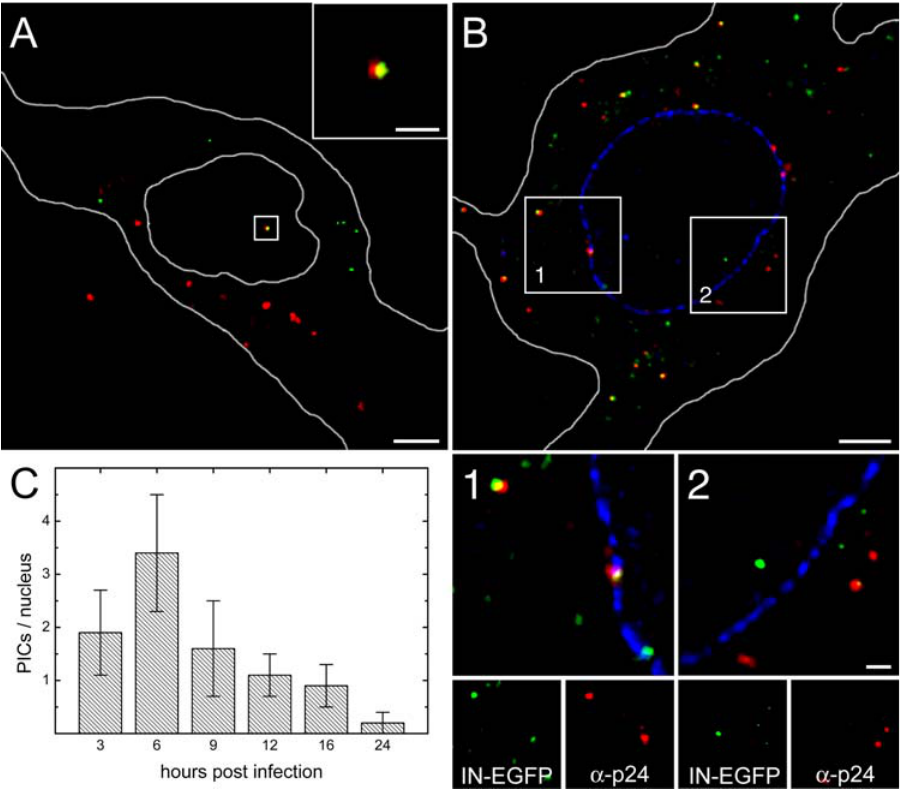
Figure 6. Nuclear HIV-IN-EGFP virions are functionally intact. (A) Merged image of a confocal section obtained from HeLa cells infected with HIV-IN-EGFP supernatants incubated with deoxynucleotides Alexa-594-dUTP. Yellow indicates full overlapping of EGFP and Alexa-594-dUTP signals. Cell and nuclear shapes are outlined in white. Bars, 5 m m and 1 m m in the whole frame and inset box, respectively. (B) Merged image of a confocal section obtained from HeLa cells infected with HIV-IN-EGFP supernatants (green) and immunostained with antibodies anti-p24 CA (red) and lamin A/C (blue). Yellow indicates full overlapping of EGFP and anti-p24 CA signals. Cell and nuclear shapes are outlined in white. Enlargements of frames 1 and 2 are shown in bottom panels along with the individual color images. Bars, 5 m M and 1 m m in the whole frame and enlarged boxes, respectively. (C) HeLa cells infected with HIV-IN-EGFP virions were fixed and the mean number of intranuclear viral particles per nucleus was quantified at 3 hrs, 6 hrs, 9 hrs, 12 hrs, 16 hrs and 24 hrs. At each time point an average of 30 cells was analyzed and SD represented as error bars.